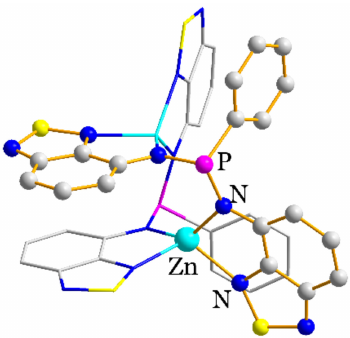
Figure 4. Molecular structure of 1 . Solvate molecules and hydrogen atoms are not shown. Crystallographically independent fragment is shown in “ball and stick” model and a symmetry related fragment is shown in “wires and sticks”